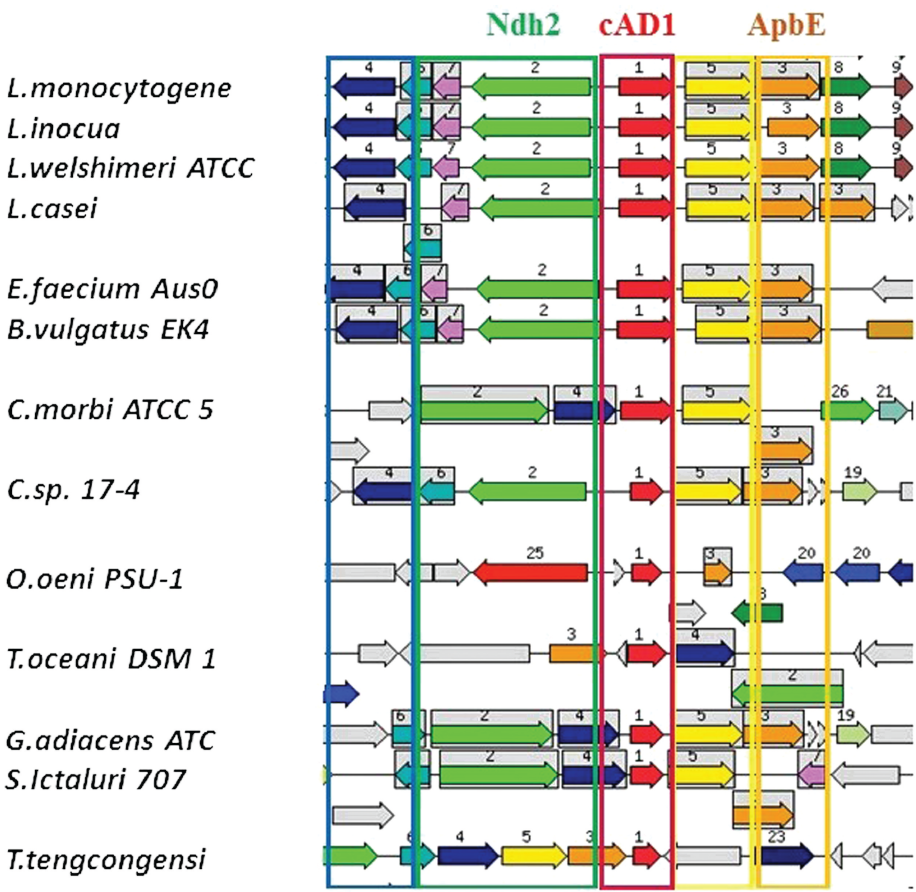
Figure 3: The genomic regions containing cAD1 precursor encoding cad gene and its close homologs retrieved from SEED